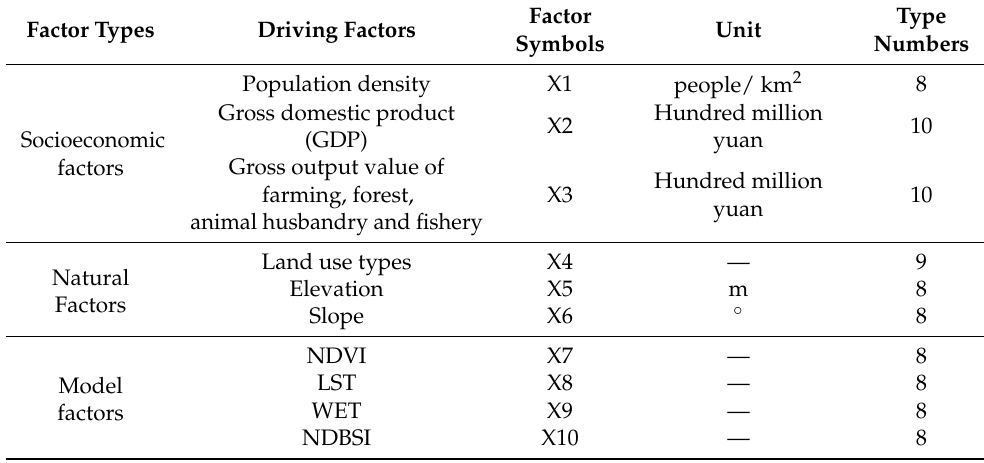
Table 2. Driving factors of environmental